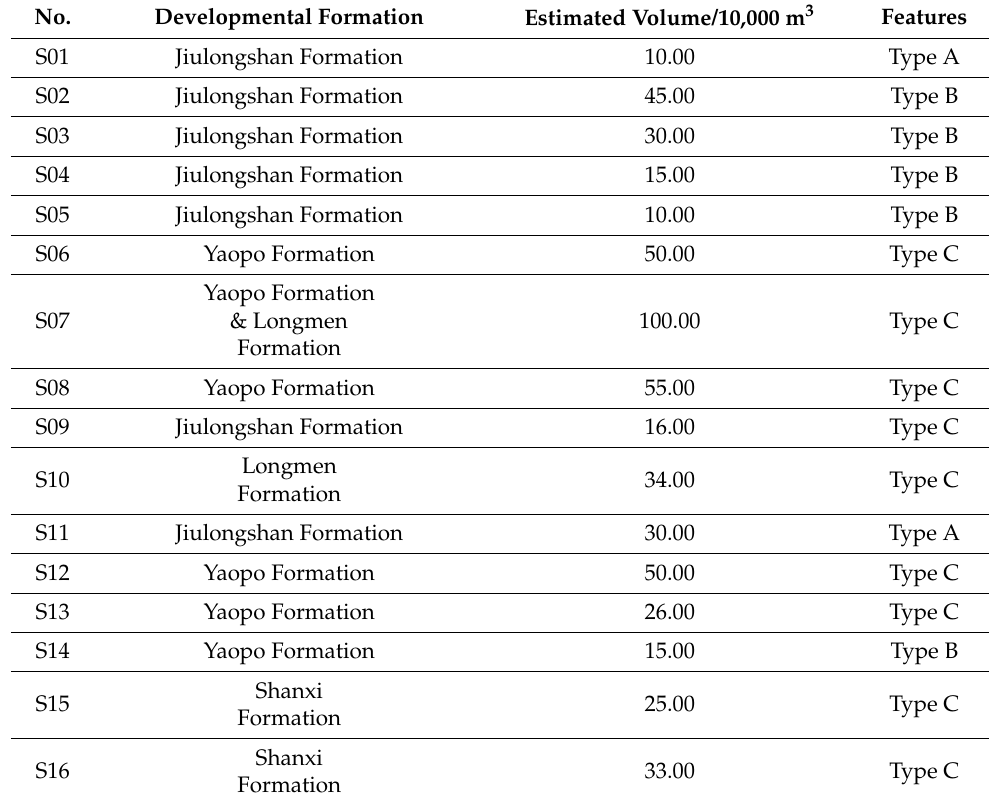
Table 3. Basic information of